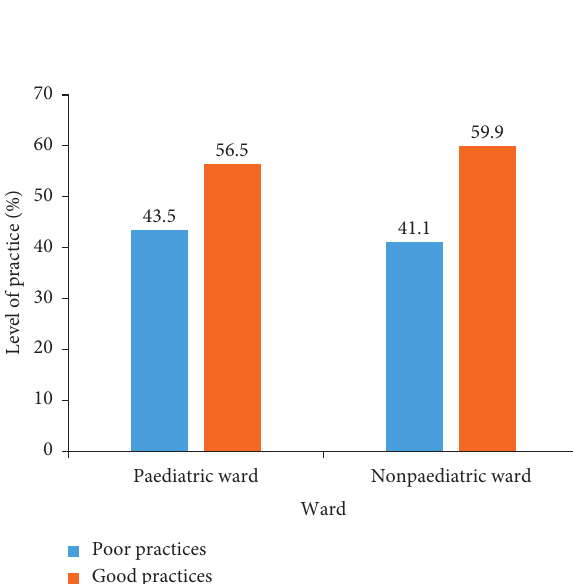
Figure 3: Overall level of practices on paediatric pain management according to ward type. Source: field data